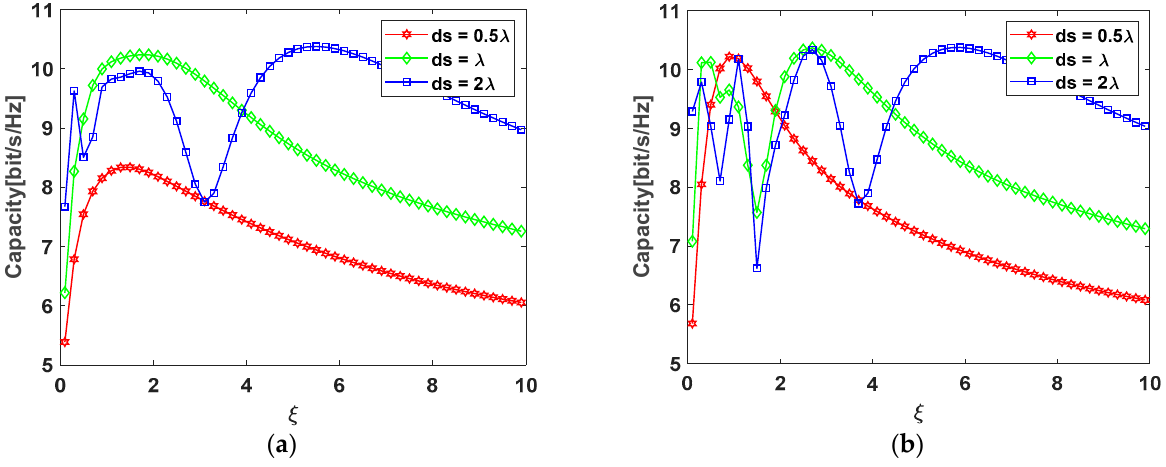
Figure 9. Channel capacity under two different 3 × 3 antenna configurations: ( a ) circular arc antenna array; ( b ) rectangular antenna array.